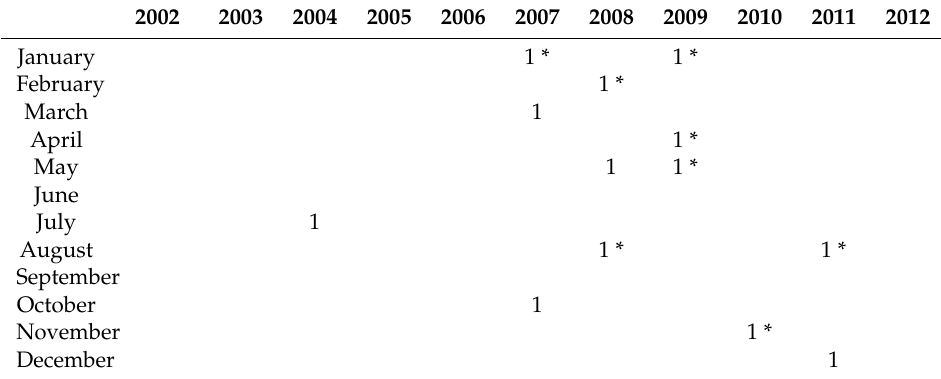
Table 5. Synchronization between the monthly field measurements and cloud-free images of MERIS sensor for Lake Kasumigaura during